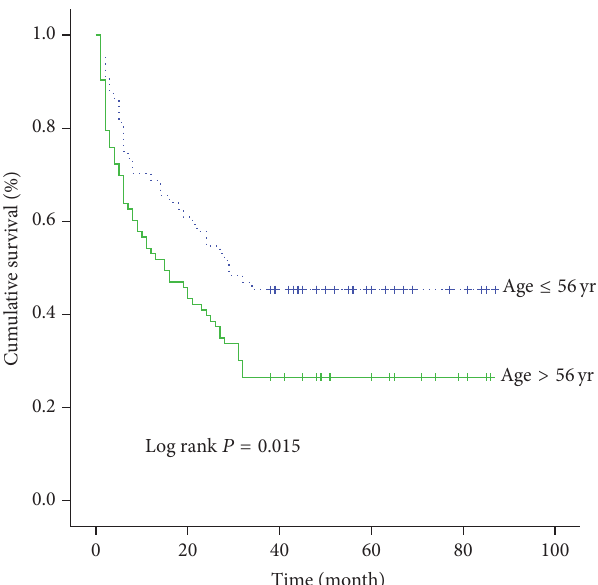
Figure 3: The cumulative survival rate of patients in stratified age groups.